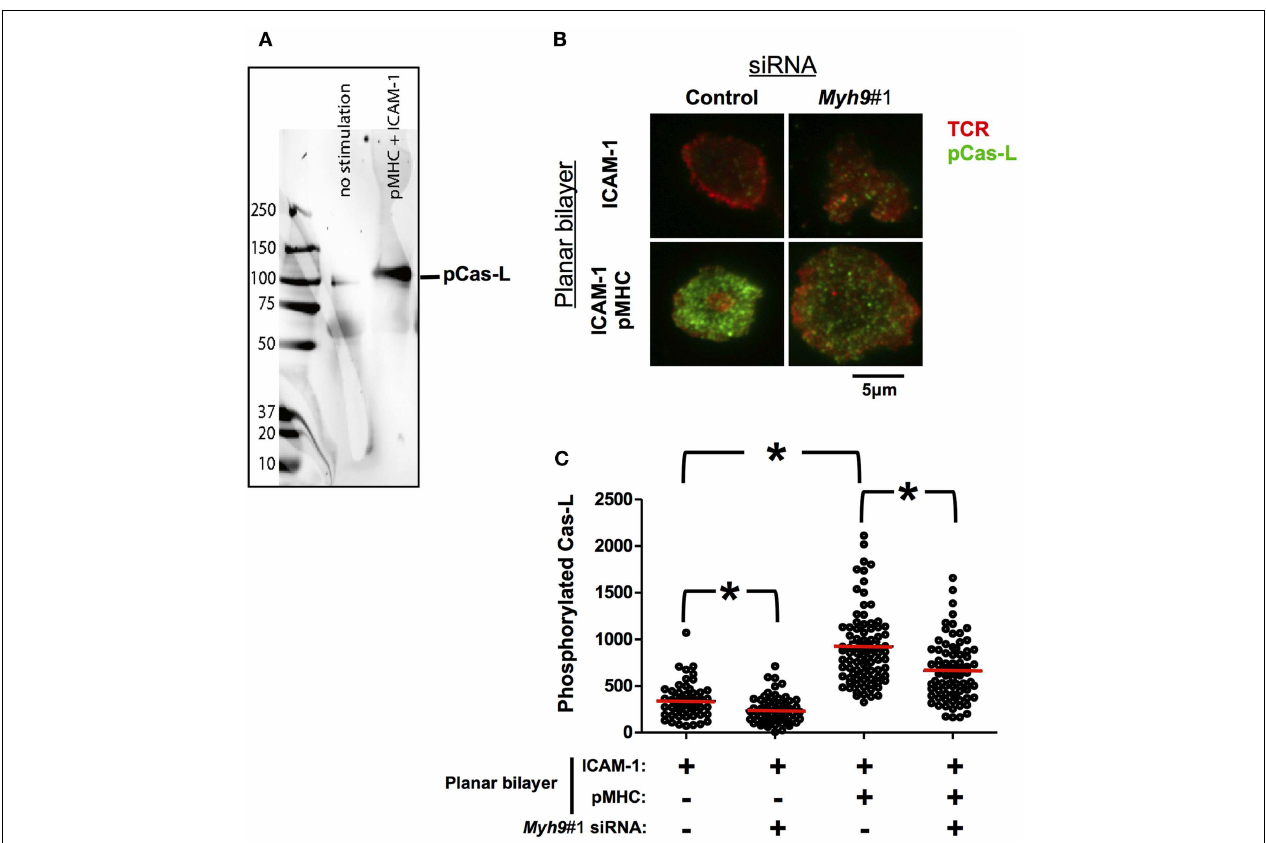
green). Both H57 and phosphorylated Cas-L signals have been contrasted to identical levels in all of the presented images. (C) Scatter plot of average intensity of phosphorylated Cas-L signal inTIRFM field, each point represents the value from one cell. Addition of I-E k -MCC to the ICAM-1 containing bilayers increased Cas-L phosphorylation 2.8-fold ( p < 0.0001, Mann–Whitney U -test) In Myh9 #1 siRNA-treated cells phosphorylated Cas-L (pCas-L) is reduced to 70% compared to control siRNA-treated cells ( p < 0.0001, Mann–Whitney U -test).The red bars show the mean intensity.The experiment was repeated three times with similar